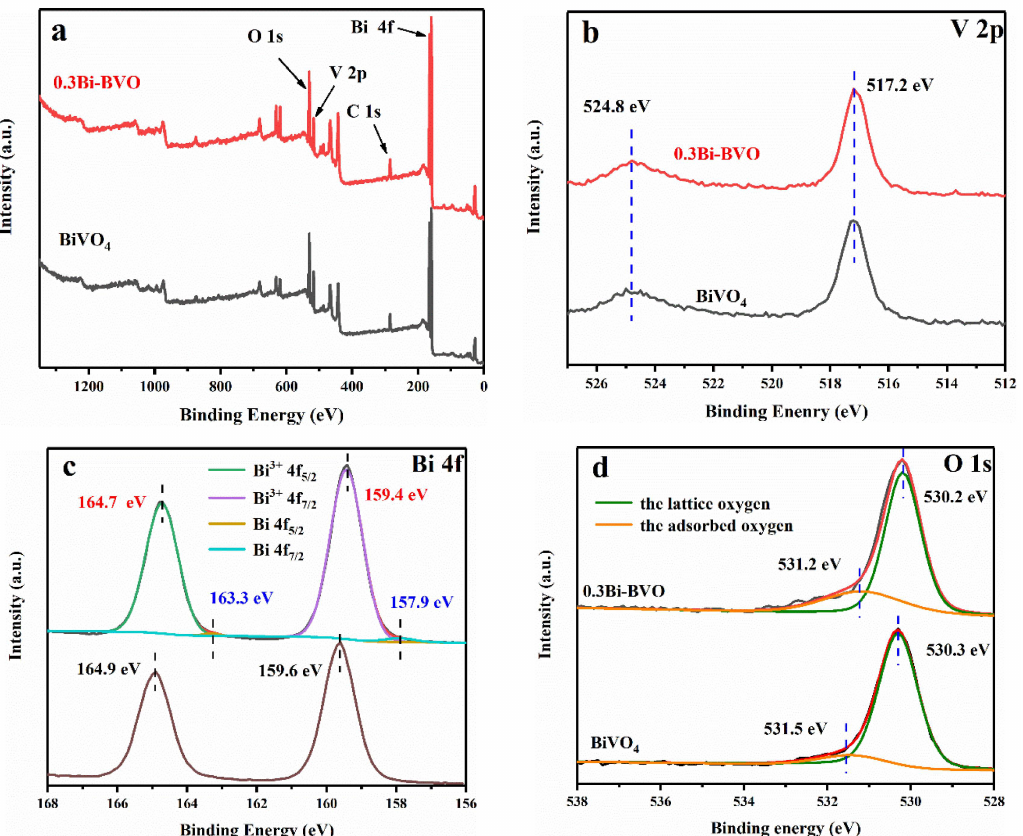
Figure 3. XPS spectra of 0.3Bi-BVO substances: ( a ) survey spectra, ( b ) V 2p spectra, ( c ) Bi 4f spectra, and ( d ) O 1s